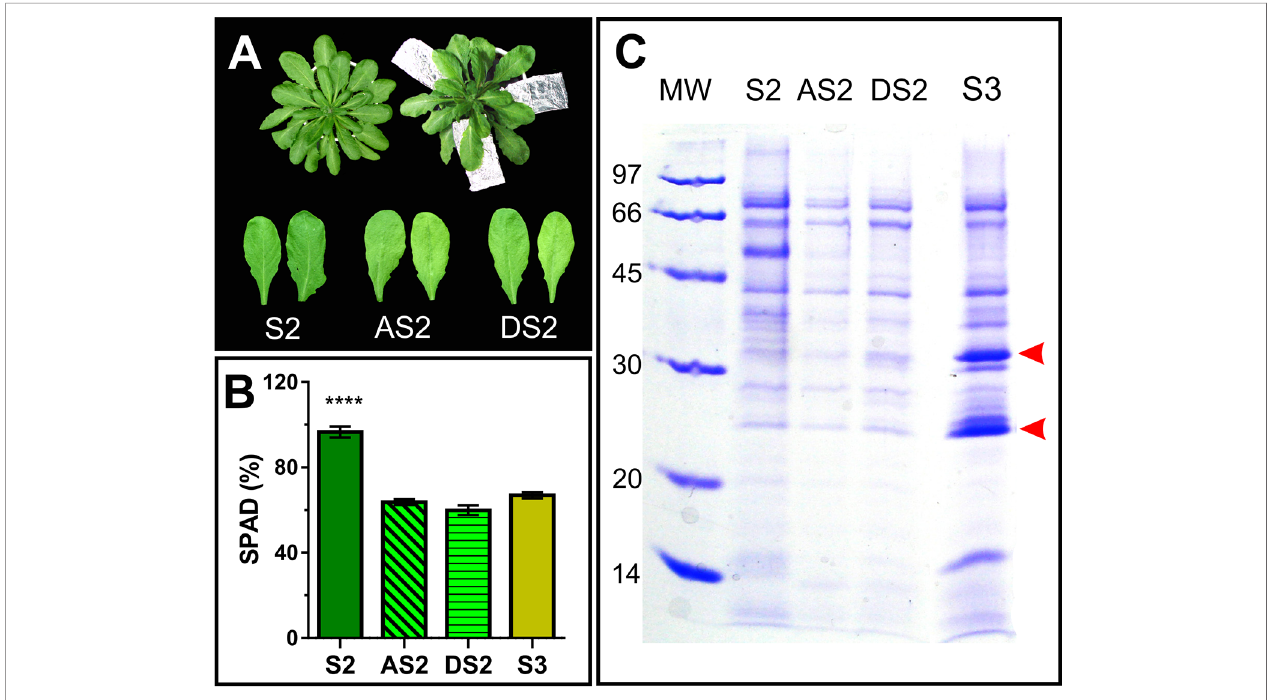
FIGURE 6 | Dark induced senescence of S2 leaves. (A) Attached S2 leaves (AS2) were wrapped in aluminum foil, and detached S2 leaves (DS2) were placed on moist fi lter paper in dark boxes, until their chlorophyll content reached S3 values ( Figure 1 ). (B) Leaf chlorophyll content was measured non-destructively with the SPAD meter in different leaves, each of them represents a biological sample (n). S2: n = 29, AS2: n = 22, DS2: n = 5, S3: n = 18. For each biological sample, two SPAD readings were taken. Asterisks represent statistical differences between S2 vs. AS2, DS2 and S3 SPAD values (Dunnett's multiple comparisons test). (C) SDS-PAGE of AF from S2, dark induced attached and detached S2 (AS2 and DS2, respectively) and S3 leaves, compared per leaf area. Arrowheads show AF S3- associated